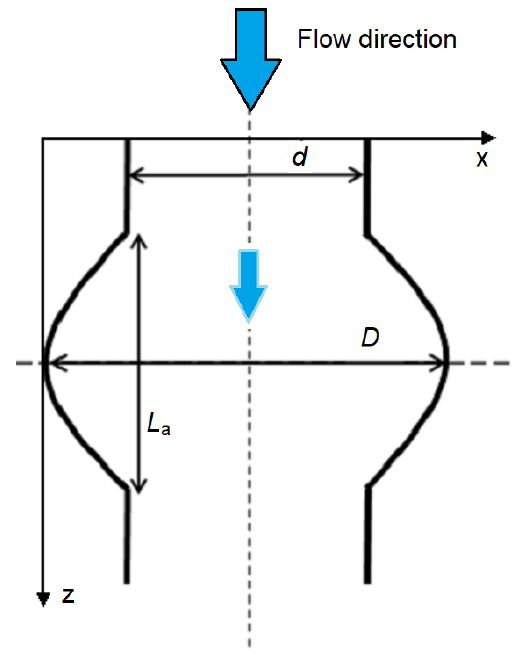
Figure 1. Experimental set-up.